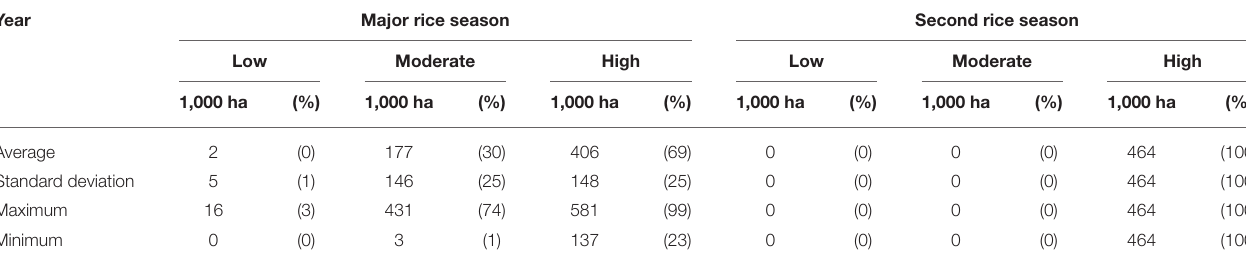
TABLE 6 | Statistical summary of the inter-annual variation of AWD suitability assessment.